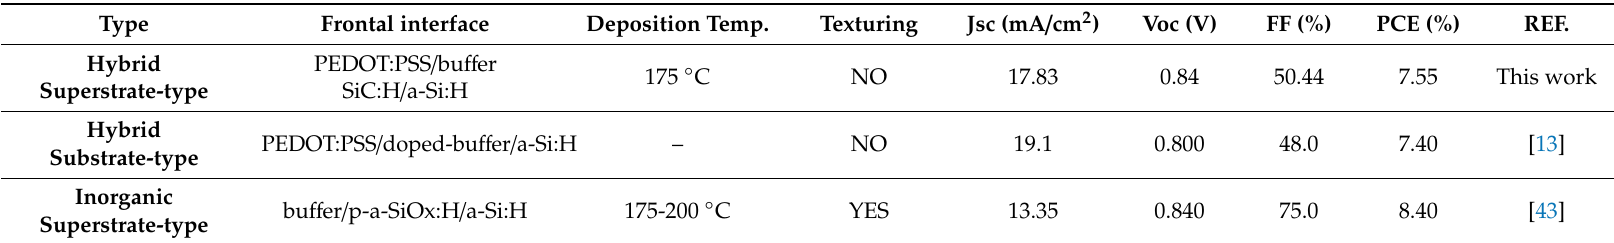
Table 4. Comparison of performance parameters of hybrid photovoltaic structure fabricated in this work and similar structures reported in